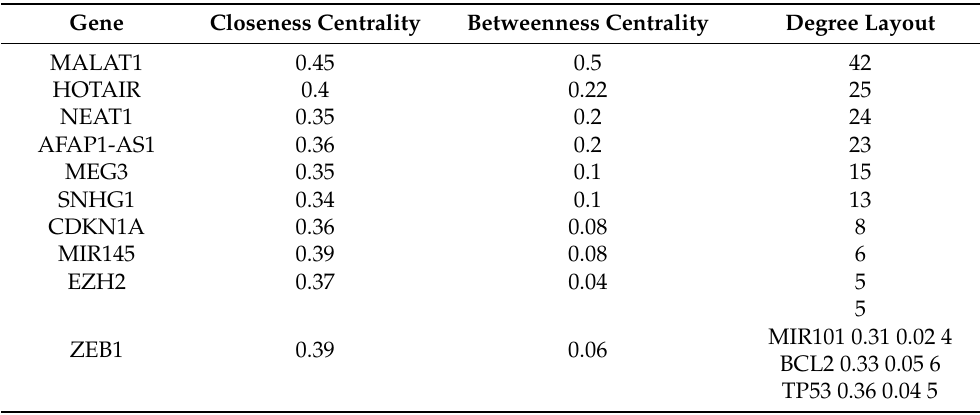
Table 4. Details of hub genes identified from lncRNA-miRNA-mRNA network. Gene Closeness Centrality Betweenness Centrality Degree Layout MALAT1 0.45 0.5 42 HOTAIR 0.4 0.22 25 NEAT1 0.35 0.2 24 AFAP1-AS1